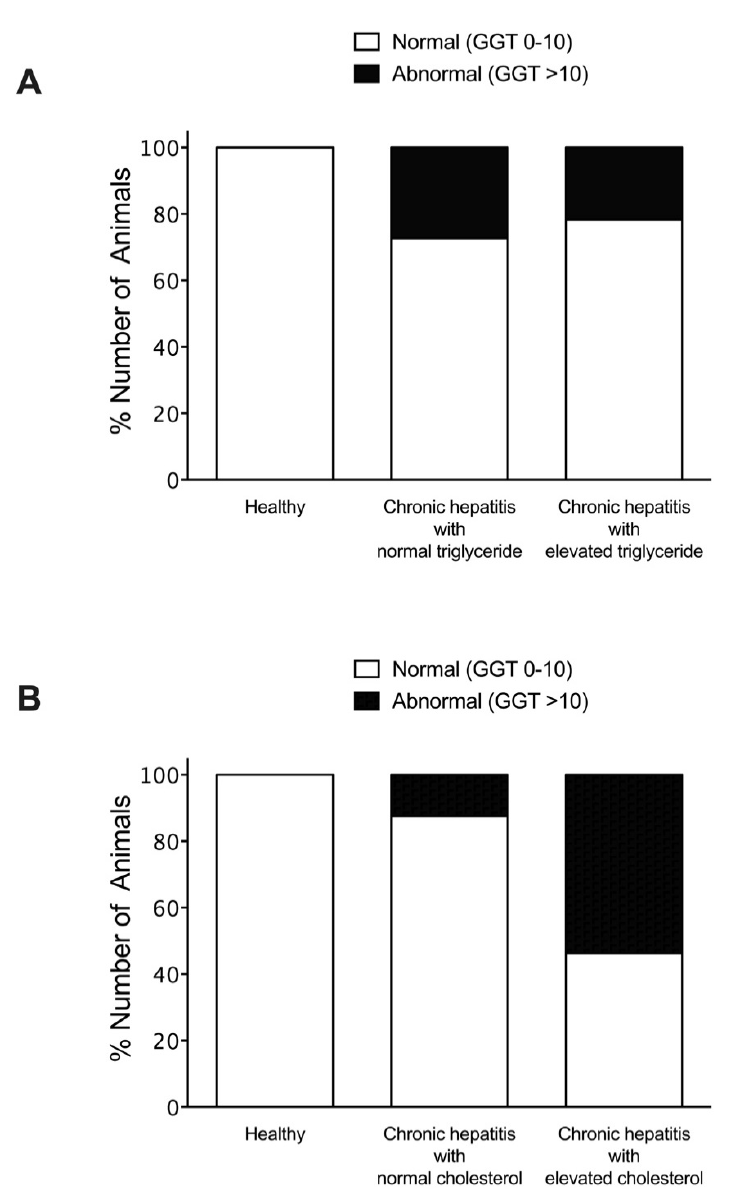
Figure 4. Histogram illustrating serum GGT concentrations of healthy dogs and dogs with chronic hepatitis, classified by triglyceride levels ( A ) or cholesterol levels ( B ). The magnitude of serum GGT concentration was divided into normal and abnormal.